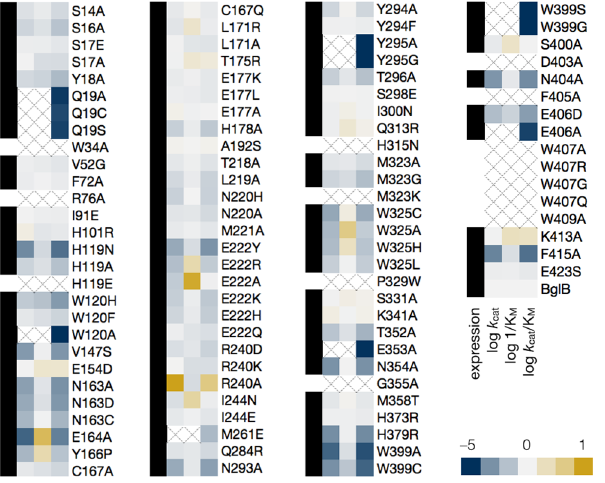
Fig 2. Log scale relative kinetic constants of 100 BglB mutants. The heatmap depicts the effect of each mutation on each kinetic constant relative to native BglB, normalized at 0. As indicated in the color legend, gold is for higher value and blue for a lower value. The metric 1/K M is used so a higher value is consistently corresponding to a “ better ” kinetic constant (assuming a lower K M is better) when evaluating k cat , k cat /K M , and K M . If the kinetic constant was not measurable, an X is depicted in the box. Proteins that were expressed as soluble protein with a final purification concentration of > 0.1 mg/mL and validated by SDS-PAGE are labeled with a black box in the first column. Those below our limit of detection of 0.1 mg/mL are labeled with an empty box. Values are on a log scale and the ranges are as follows: 10 – 11,000 min -1 ( k cat ), 0.6 – 85 mM (K M ), and 10 – 560,000 M -1 min -1 ( k cat /K M ) with wild type constants of 880 ± 10 min -1 , 5.0 ± 0.2 mM, and 171,000 ± 8000 M -1 min -1 for